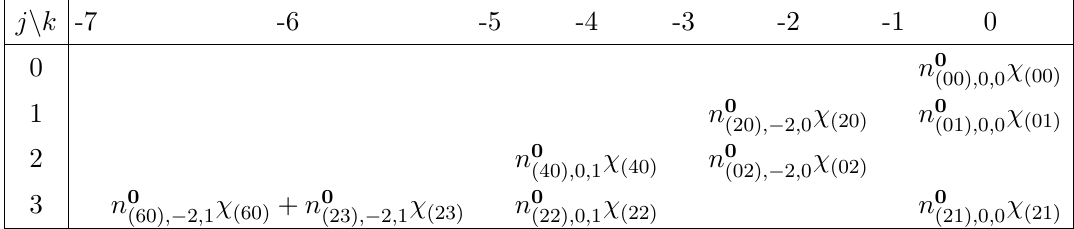
( m ) in the series expansion of (cid:24) 1 ; Sp(2) Sp(2) j;k